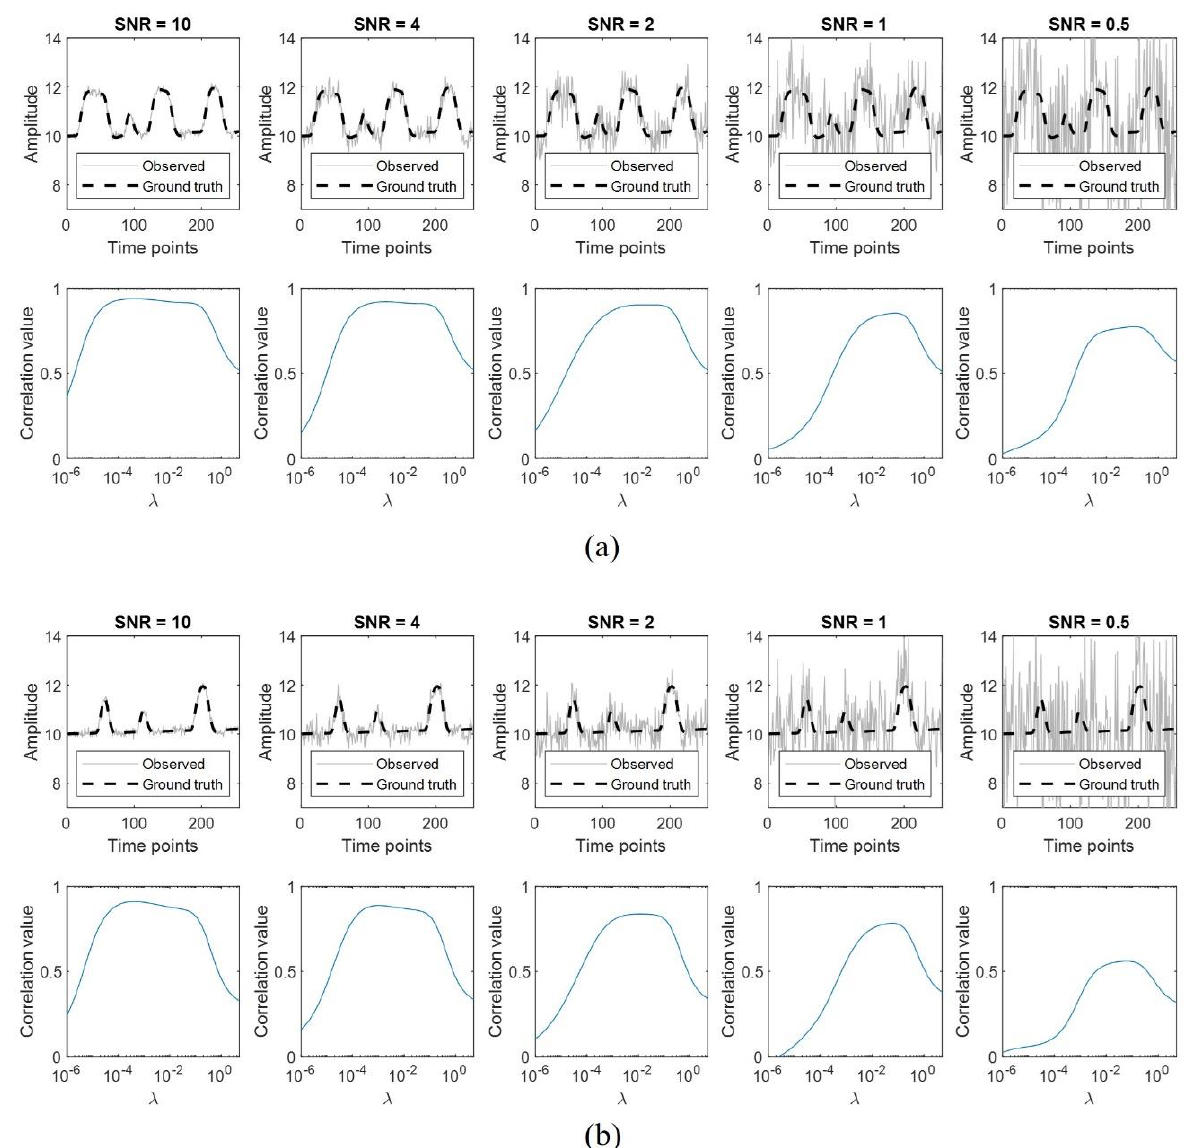
Figure A6. Effect of regularization constant ( λ ) on estimation of the pseudo-stimulus. Results shown for varying SNR for two different types of synthetic data ( a , b ). Each column represents results for a different SNR indicated above the top subplot. The top subplot shows the ground truth and the noise time series. The bottom subplot represents the correlation between the actual (ground truth) and the estimated (pseudo-stimulus) as a function of λ